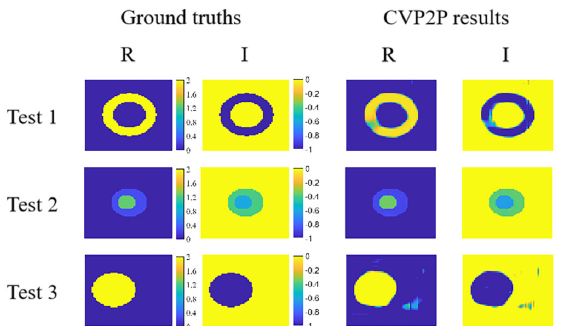
Figure 5. Example 3: Reconstructed contrast of lossy scatterers by the CVP2P are shown in the third and fourth columns, respectively. The ground truths are shown in the first two columns of Figure 5. Among them, R and I are defined as the real and imaginary parts of the complex value contrast, respectively.